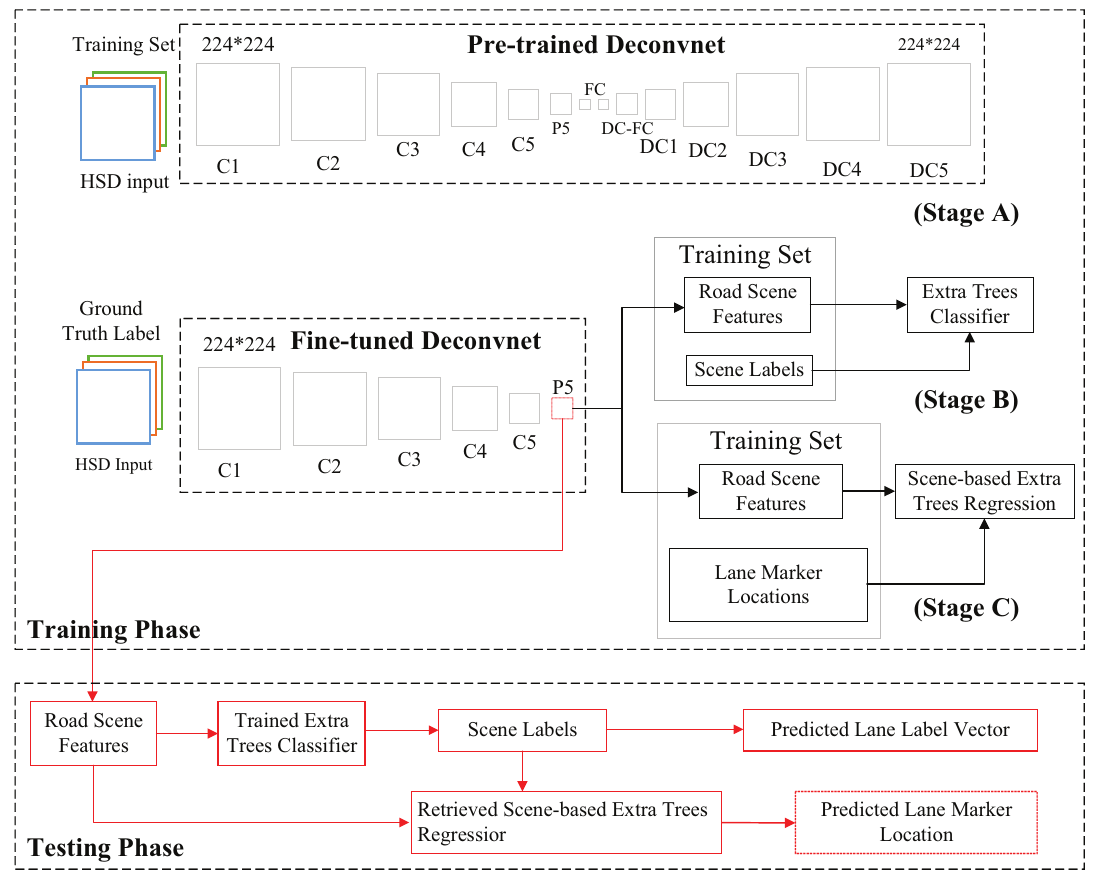
Figure 16. The training and testing process of the method in